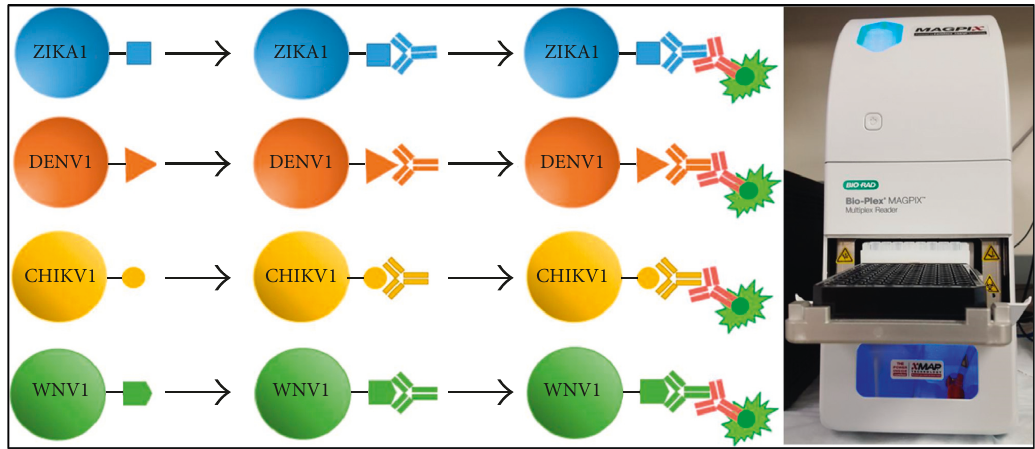
Figure 3: Illustration of the principle of a multiplex serodiagnostic assay used in the